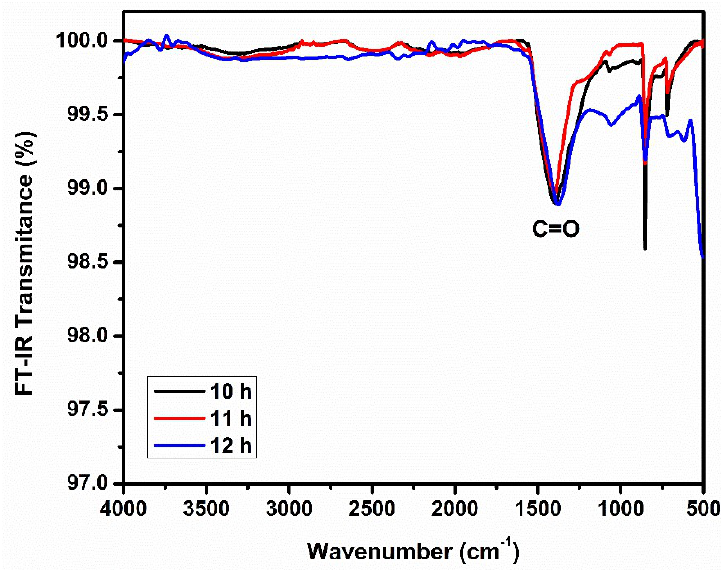
Figure 3. FTIR transmission spectra of the CdCO 3 samples deposited at 10, 11, and 12 h.